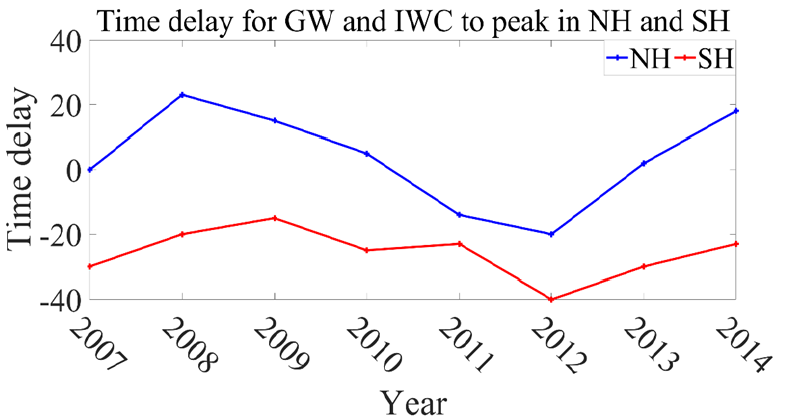
Figure 4. The time delay of the peak time for GW and IWC on each PMC season in NH (blue line) and SH (red line). In 6/8 seasons of NH, when the GW activity reached its peak value, the IWC would increase and peak within 0 – 23 days. Yet in all 8 seasons of SH, the IWC started to increase ahead of GW activity. Figure 5 shows the distribution of IWC in the SH during the PMC seasons from 2007/2008 to 2014/2015. Compared with Figure 2, the GW activities in the SH were mainly concentrated in the late periods of the PMC seasons. Among them, in three seasons (e.g., 2009/2010, 2012/2013, and 2014/2015) the GW activity was the most frequent, and the cor- responding IWC varied more dramatically. The time delay for GW and IWC in the SH is also plotted in Figure 4. In the eight PMC seasons in the SH, GW peaked around 55 days after the summer solstice. Except for the 2012/2013 and 2013/2014 seasons, the IWC in the other six seasons increased about 20 days after the summer solstice. In all eight seasons, the IWC started to increase ahead of GW activity. Taking the 2009/2010 PMC season as an example, the IWC increased rapidly and peaked at 25 – 30 days after the solstice, and then gradually decreased until the end of the season. On the contrary, the GW increased and peaked about 55 days after the solstice. In the 2012/2013 and 2013/2014 seasons, the IWC began to increase even earlier than the solstice, but the GW activity peaked around 55 days after the solstice. This result indicates that the variations of IWC in the SH are un- likely to be driven by the GW activities during the PMC seasons.